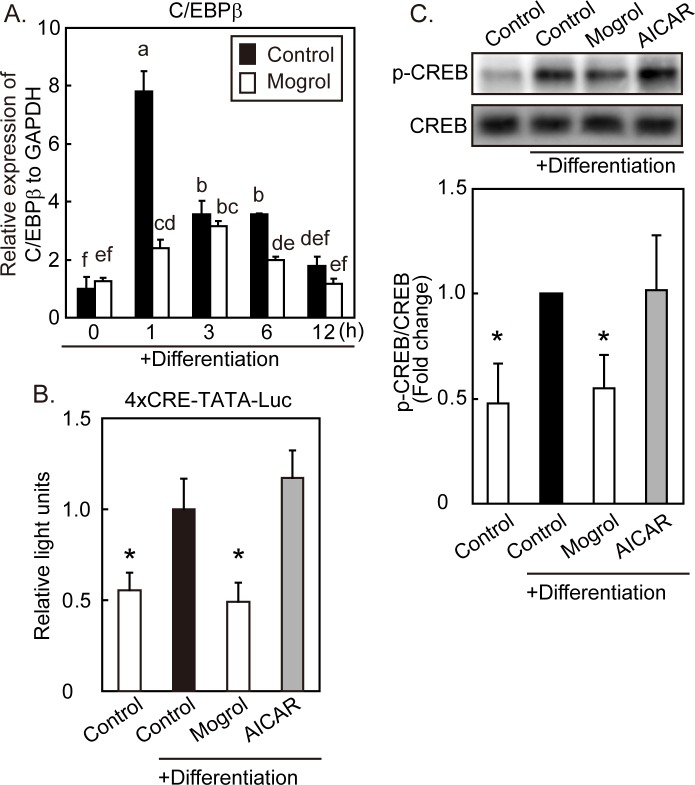
Effects of mogrol on CCAAT/enhancer-binding protein β (C/EBPβ) expression and cAMP response element (CRE)-mediated transcription.(A) On day 0, 3T3-L1 cells were pretreated with 20 μM mogrol for 30 min, and cells were stimulated by insulin, dexamethasone (DEX), and 3-isobutyl-1-methylxanthine (IBMX) for the indicated time-periods. Total RNA was extracted from the cells and the expression of C/EBPβ relative to that of glyceraldehyde-3-phosphate dehydrogenase (GAPDH) was analyzed by real-time PCR. Different letters mean statistically significant differences, determined by one way ANOVA with Tukey’s post-hoc test. (B) Two days before day 0, 3T3-L1 cells were transfected with p4xCRE-TATA-Luc and pGL4.74[hRluc/TK]. On day 0, the medium was exchanged to differentiation medium and the cells were stimulated with 0.5 mM IBMX for 24 h prior to the determination of luciferase activities. *p < 0.05 for the comparison with cells differentiated in the absence of mogrol (solid black bar), one way ANOVA with Dunnett’s post-hoc test. Data indicate the mean ± SD and are representative of three independent experiments with similar results. Error bars represents the SD of three (A) or four (B) replicates. (C) On day 0, cells that had been pretreated with mogrol or AICAR for 30 min in differentiation medium were stimulated by differentiation initiators for 5 min. The cell lysates were then analyzed for cAMP response element-binding protein (CREB) or phosphorylated CREB (p-CREB) by Western blotting. Photographs are representative of four independent experiments with similar results. The band intensity of phosphorylated CREB was expressed relative to the band intensity of total CREB. Error bars represent the SD of four independent experiments; *p < 0.05 for the comparison with cells differentiated in the absence of mogrol (solid black bar), one way ANOVA with Dunnett’s post-hoc test.